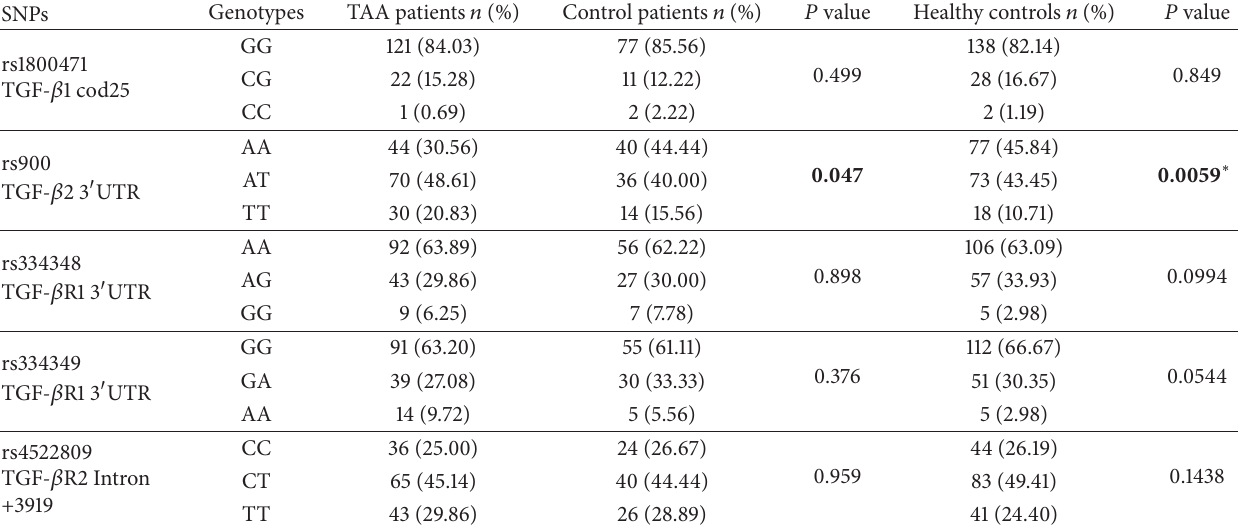
Table 4: Genotype frequencies of TGF- 𝛽 1 and 2 isoform and R1 and R2 receptor gene single nucleotide polymorphisms in patients affected by sporadic TAA and the two groups of controls subjects.